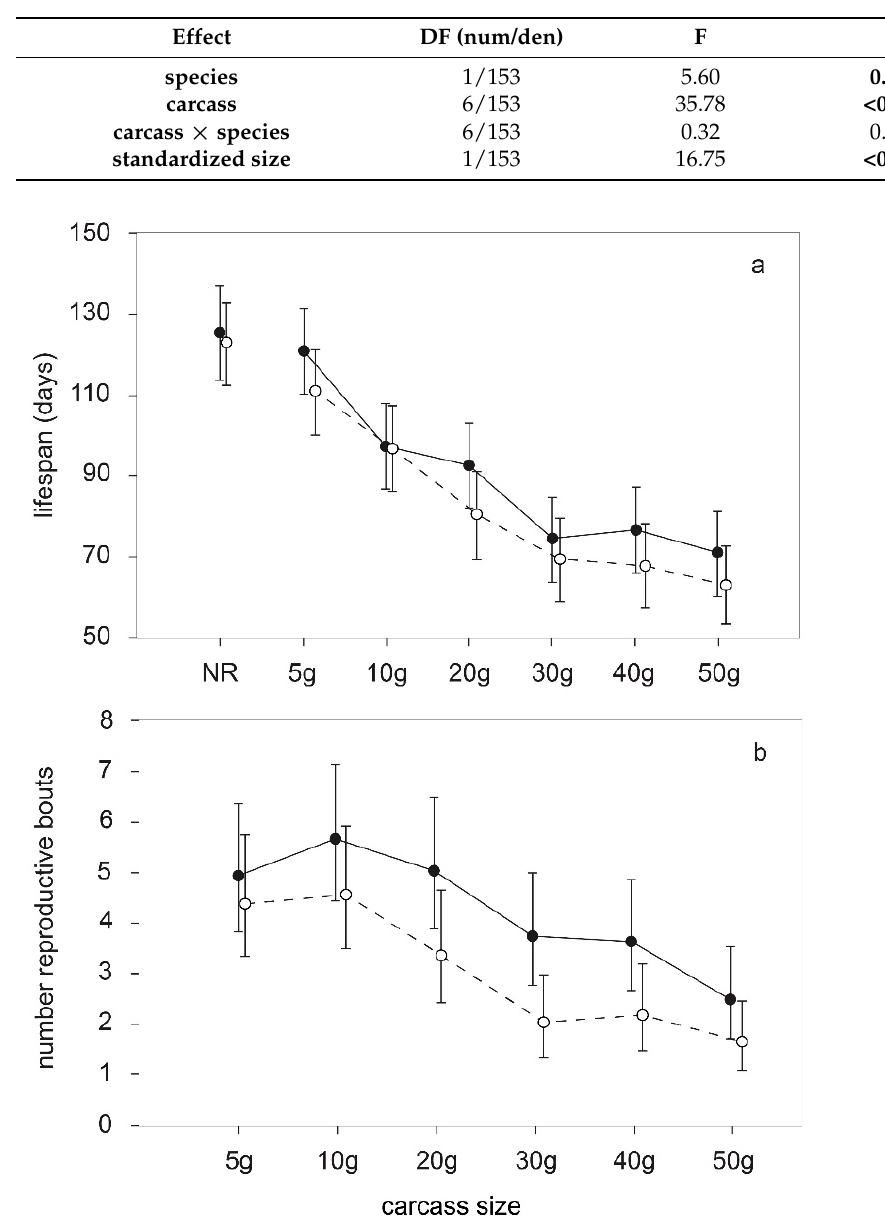
Table 3. Results of ANCOVA for number of reproductive bouts. Significant effects are bolded. Table 2. Results of ANCOVA for lifespan. Significant effects are bolded.